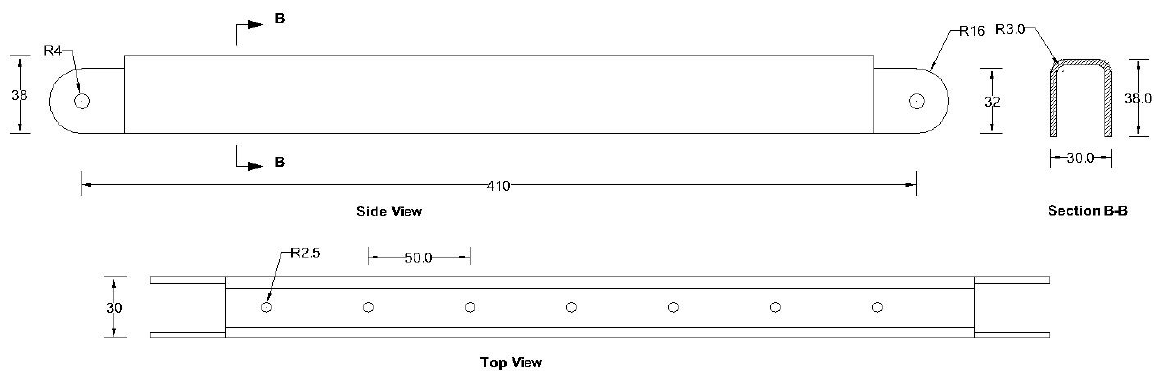
Figure 9. Details of Secondary bars (all dimensions are in mm, steel plate gauge 11).